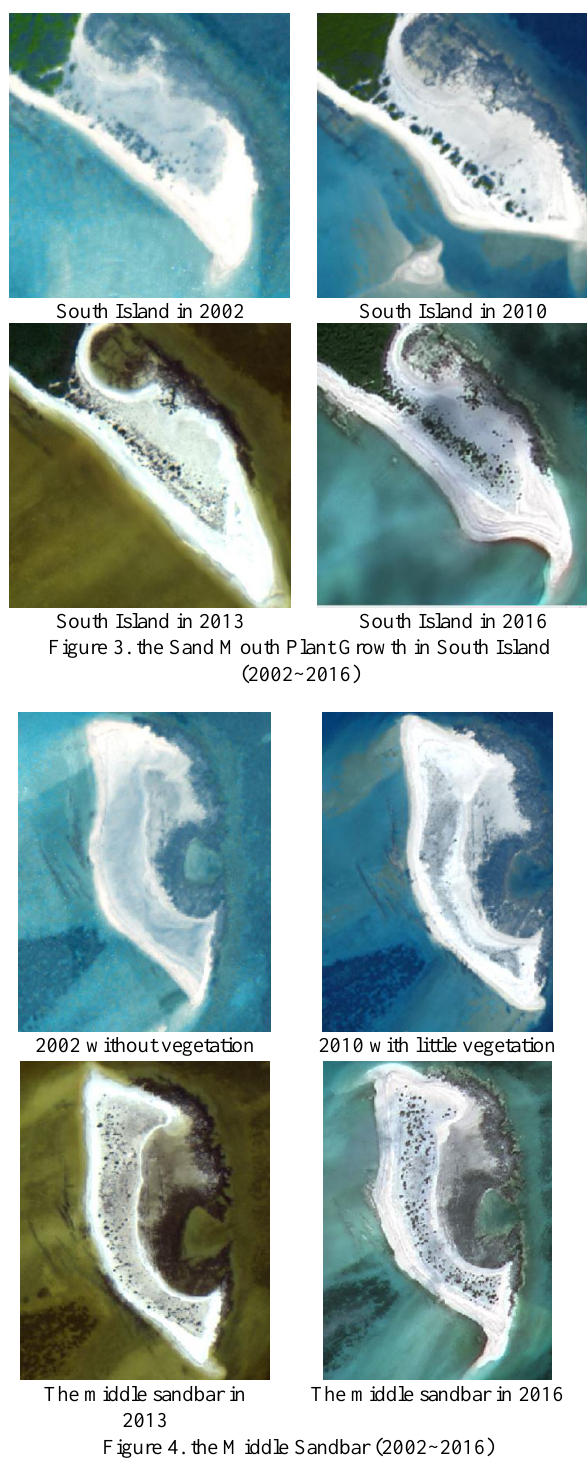
Figure 4. the Middle Sandbar (2002~2016)